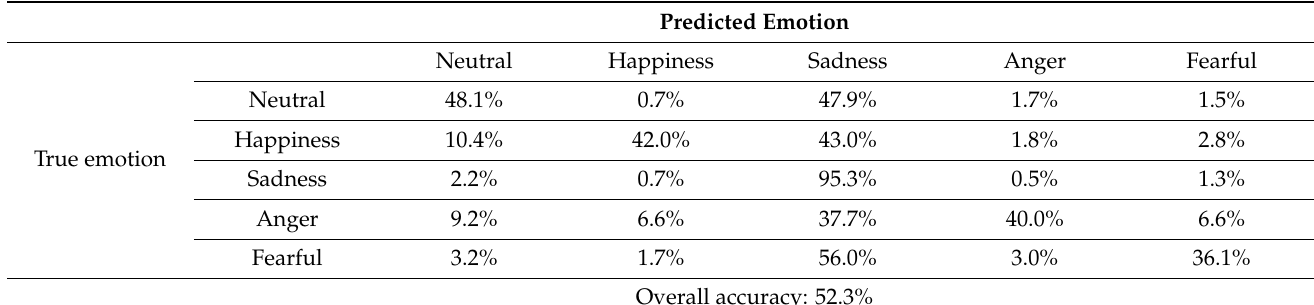
Table 2. Confusion matrix of the emotion classification results of the baseline CNN that was trained on the Korean CADKES mixed with the PCAFETER noise.